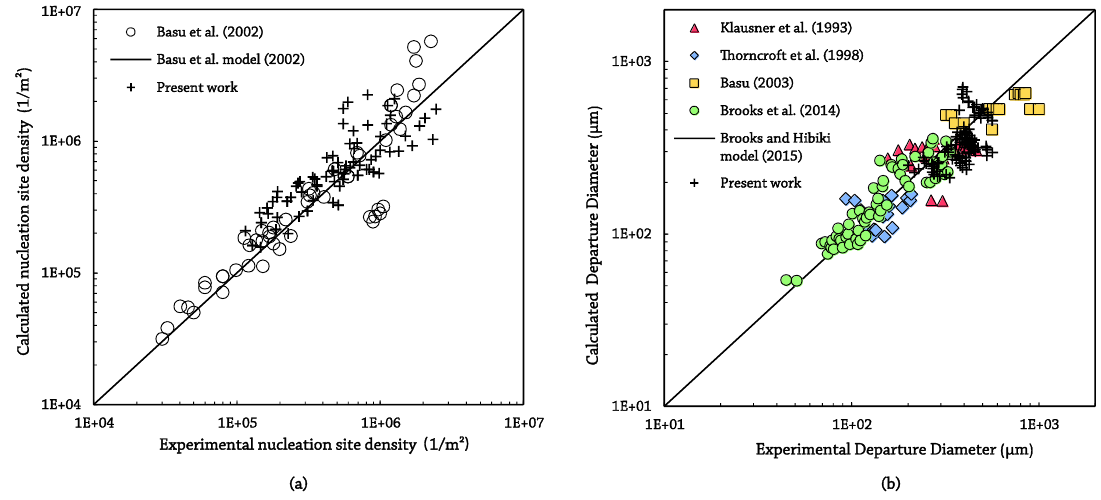
Figure 15. Validation results: MV output against data from other researchers: ( a ) nucleation site density; ( b ) bubble diameter.